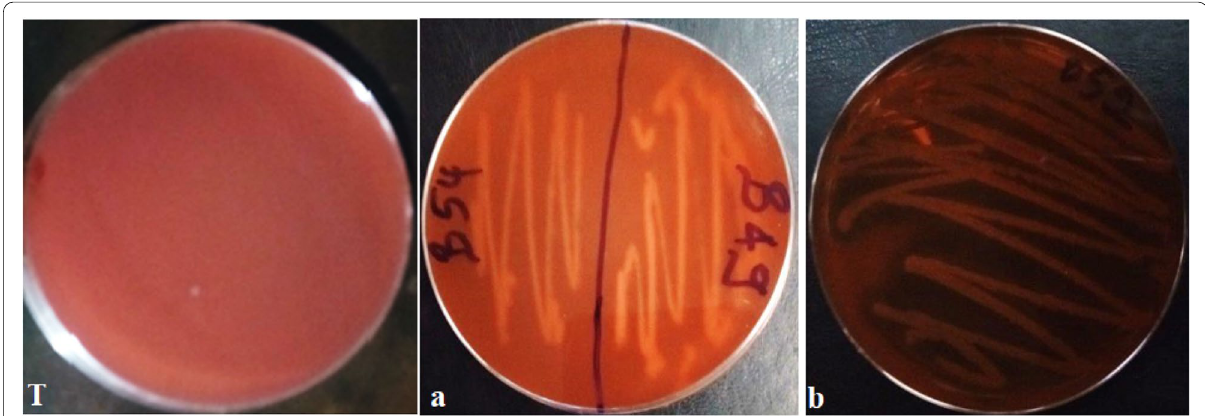
Fig. 3 Hemolytic activity of Bacillus strains. Legend: T